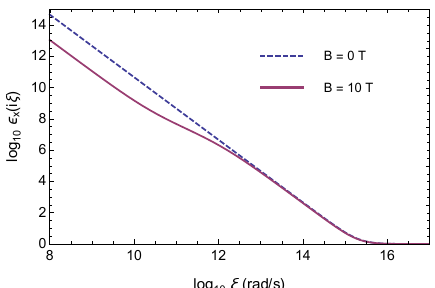
Figure 2. Permittivity parallel to the surface of YBCO in the mixed state at T = 8.82 K ( t = 0.1) along imaginary axis in a log–log scale.